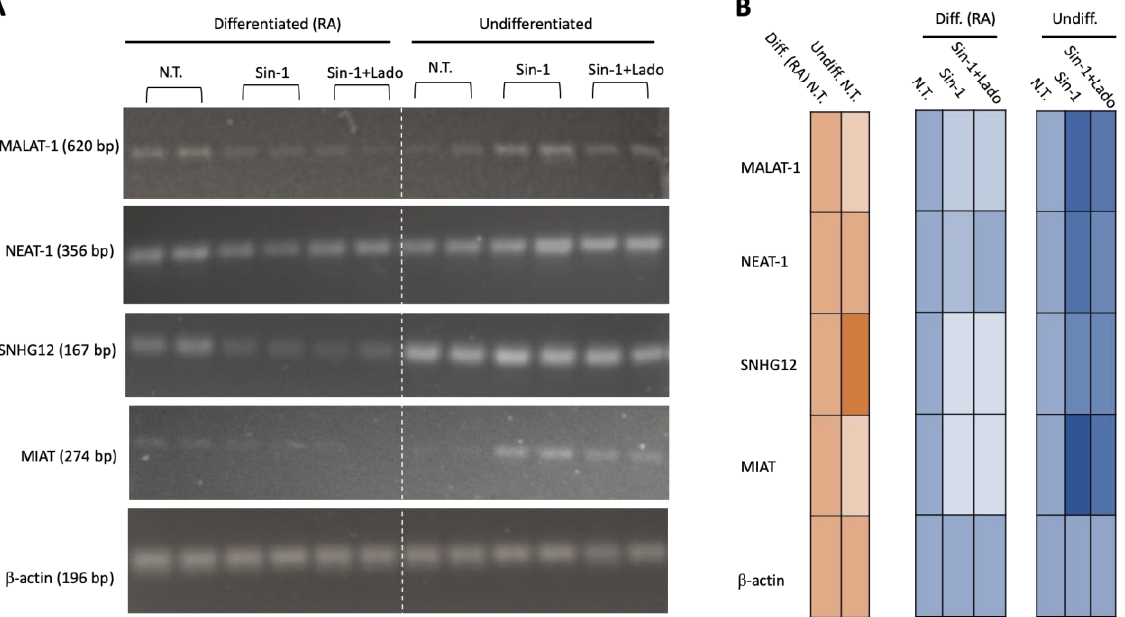
Figure 6. Differentially expressed (DE) ncRNAs following 24 h of exposure to Sin1 relative to untreated cells. ( A ) RT-PCR results on Agarose gel. The RT-PCR product of β -actin was used as an internal control. Each condition is shown for two biological duplicates. The indicated ncRNA results are for the untreated culture (N.T.) and cells in the presence of Sin1, and Sin1 and ladostigil (5.4 μ M). ( B ) Quantification of the results in (A) by a heatmap visualization. Orange, comparison of the baseline of the untreated cells. Blue, changes in cells by Sin1, and Sin1 and ladostigil (5.4 μ M).